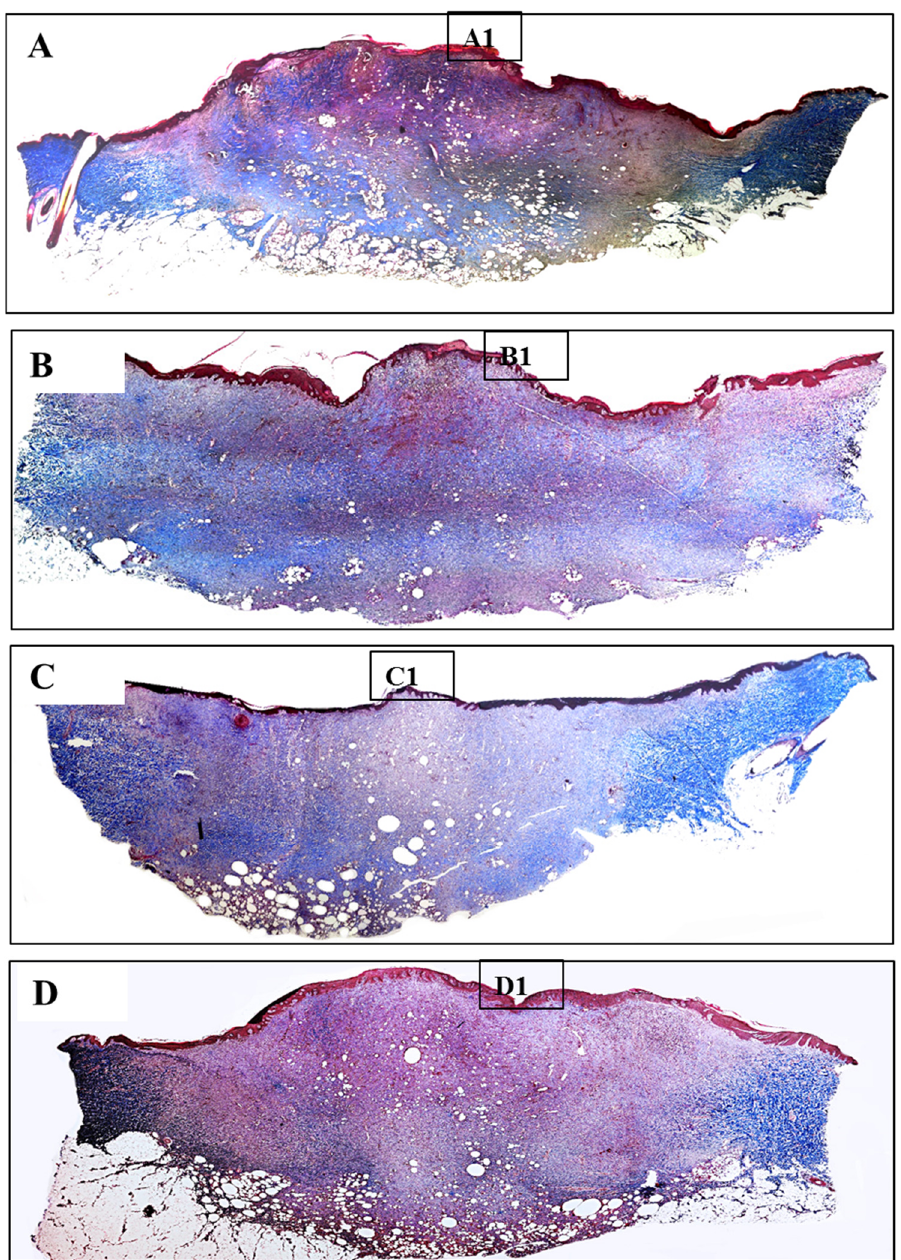
Figure 10. MT-stained sections of wounds treated with ( A ) normal gauze, ( B ) Aquacel, ( C ) UrgoTul, and ( D ) PCLGelAg membranes. The black square boxes ( A1 – D1 ) show the epidermis and a part of the dermis in the center of the wounds, respectively.